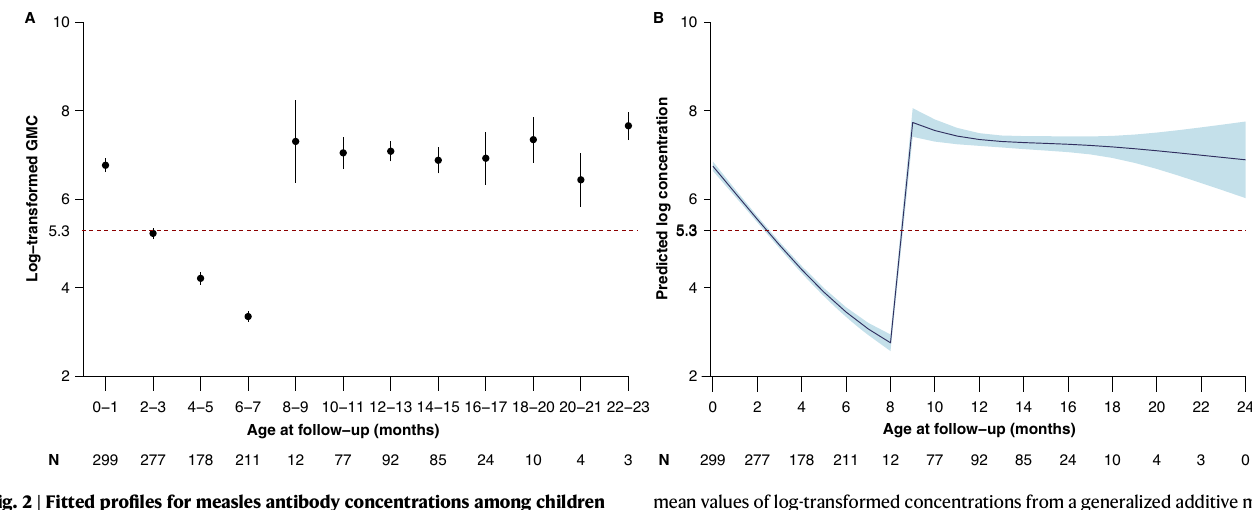
mean values of log-transformed concentrations from a generalizedadditive mixed model. Error bars and shaded areas show 95% con fi dence intervals. Horizontal red dashedlinesrefertoaprotectivethresholdof200mIU/ml.Inthebottompanel,the letter N refer to the sample size used to derive the error bars and shaded